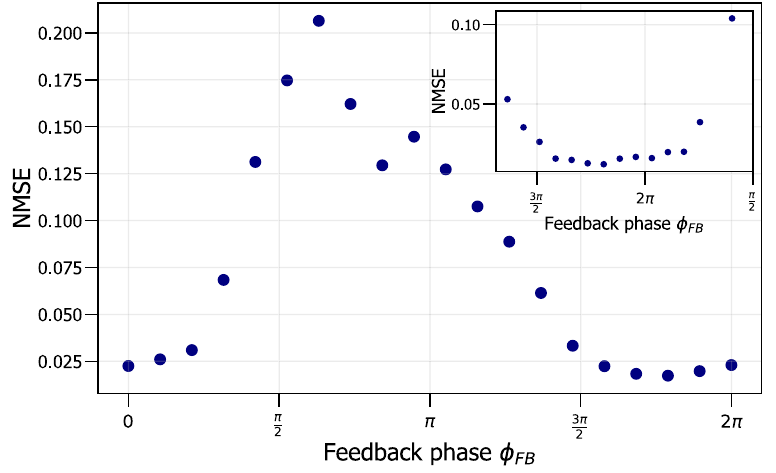
Figure 5: NMSE as a function of the feedback phase of the RC system, for one-step ahead prediction of Santa Fe data, with a zoomed in plot in the top right